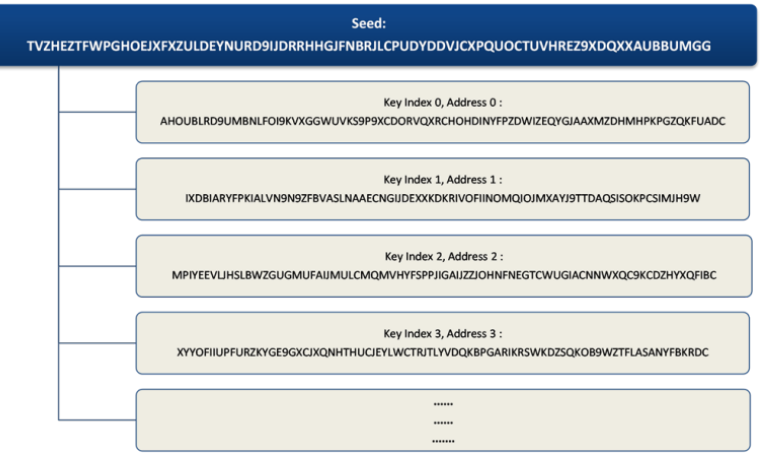
Figure 6. Address generation from